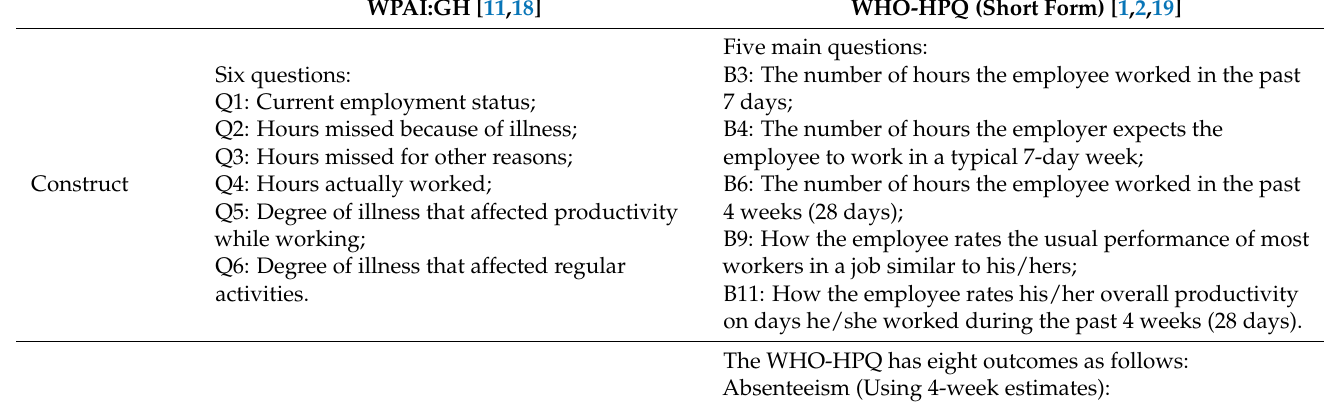
Table 1. Items in the Work Productivity and Activity Impairment Questionnaire: General Health (WPAI:GH) and the World Health Organization’s Health and Work Performance Questionnaire (WHO-HPQ).